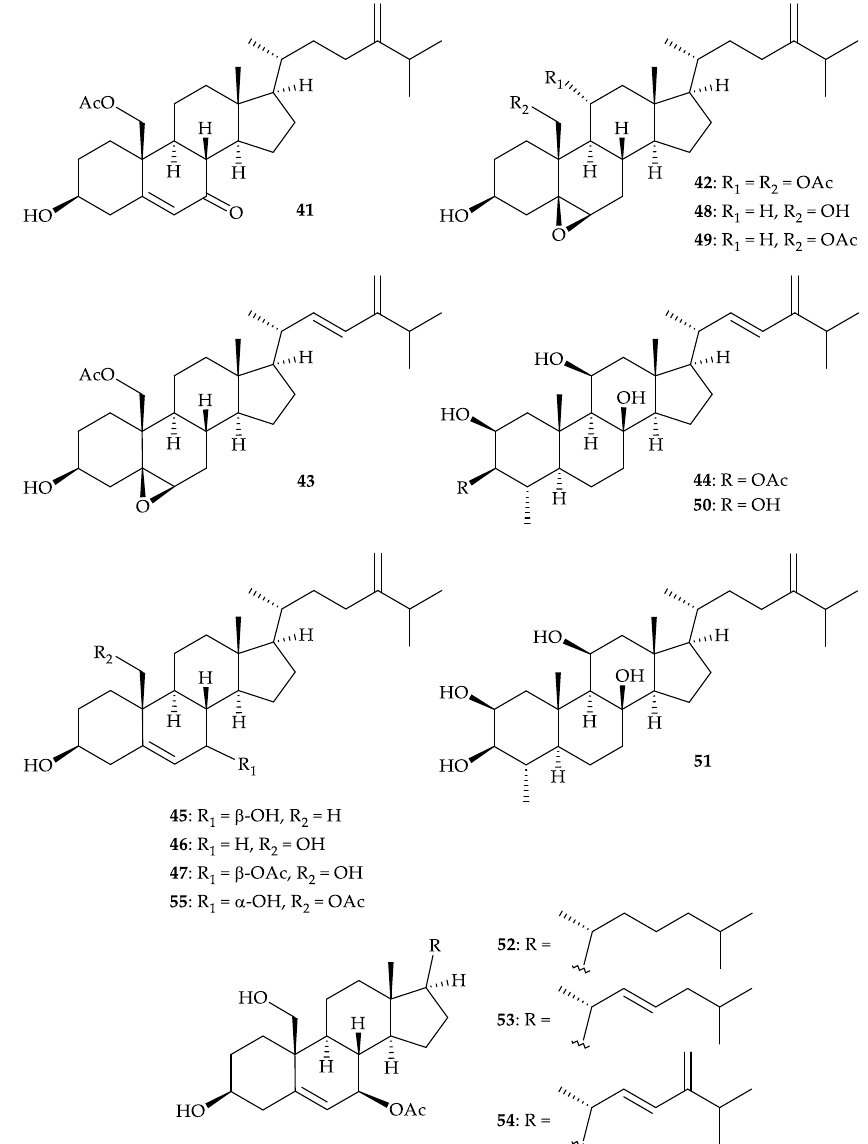
Figure 8. Structures of 7-dehydroerectasteroid F ( 41 ), 11α-acetoxyarmatinol A ( 42 ), 22,23-di-dehydroarmatinol A ( 43 ), 3- O -acetylhyrtiosterol ( 44 ), 24-methylene-5-cholesten-3β,7β-diol ( 45 ), 24-methylene-5-cholesten-3β,19-diol ( 46 ), 24-methylene-5-cholesten-3β,19-diol-7β-monoacetate ( 47 ), 5,6-epoxylitosterol ( 48 ), armatinol A ( 49 ), hyrtiosterol ( 50 ), (2β,3β,4α,5α,8β,11β)-4-methylergost-24 (28)-ene-2,3,8,11-tetrol ( 51 ), and erectasteroids C–F ( 52 – 55 ). 3. Dendronephthya griffini (Roxas, 1933) Ten new steroids, griffinisterones A–I ( 56 – 64 ) and griffinipregnone ( 65 ) (Figure 9), were obtained from D. griffini specimens collected by a bottom trawl net at depths from 200 to 100 m at Taiwan Straight in December 2004 [61,62]. The structures of steroids 56 – 65 were determined by spectroscopic methods and the configuration of griffinisterone A ( 56 ) was further confirmed by a single-crystal X-ray diffraction analysis [61,62]. The absolute stereochemistry of griffinisterone E ( 60 ) was determined by the application of a modified phenylglycine methyl ester (PGME) method [61].